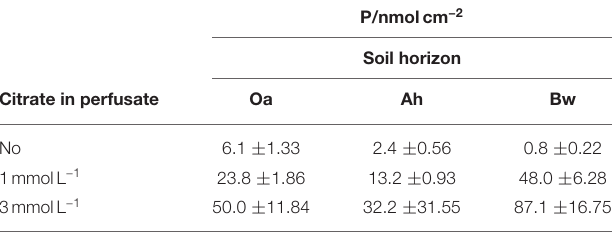
TABLE 2 | Cumulative phosphate influx (medians ± 95%confidence limits) into MD probes during 6 days